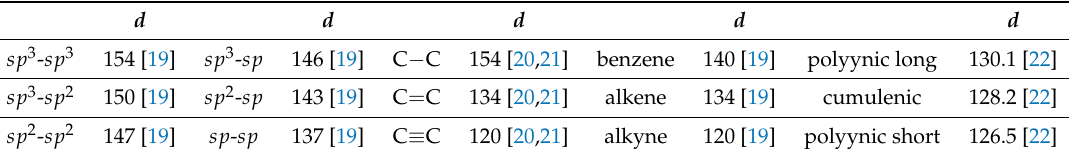
Table 1. Carbon–carbon bond lengths d (pm) in organic compounds.